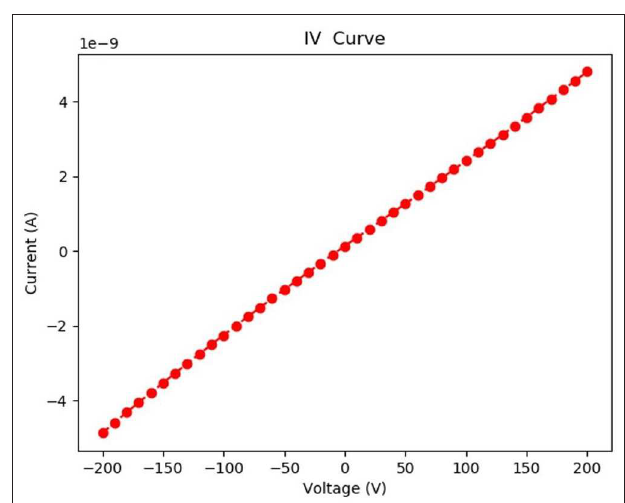
FIGURE 7 | Current-voltage (IV) characteristic curve for 6 LiInSe 2 -G77-6 sample. The resistivity of the sample is evaluated to be 3.0 × 10 11 (cid:127) cm, for the sample with 0.7mm thickness and 8mm Fe contact